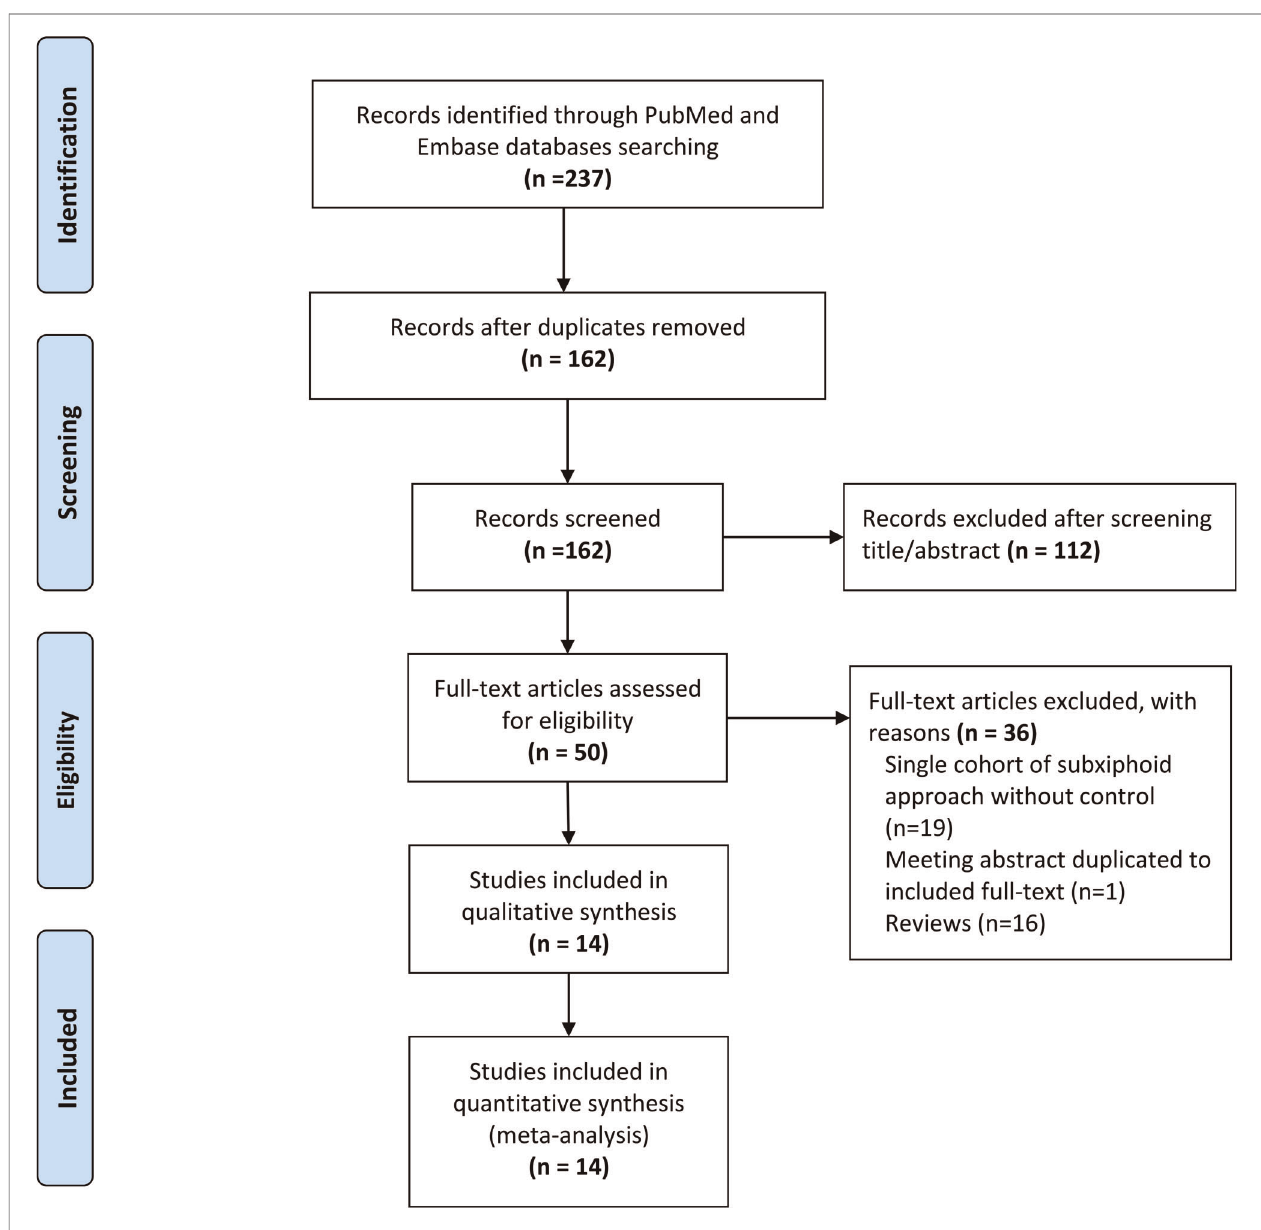
FIGURE 1 | Flow chart of the selection